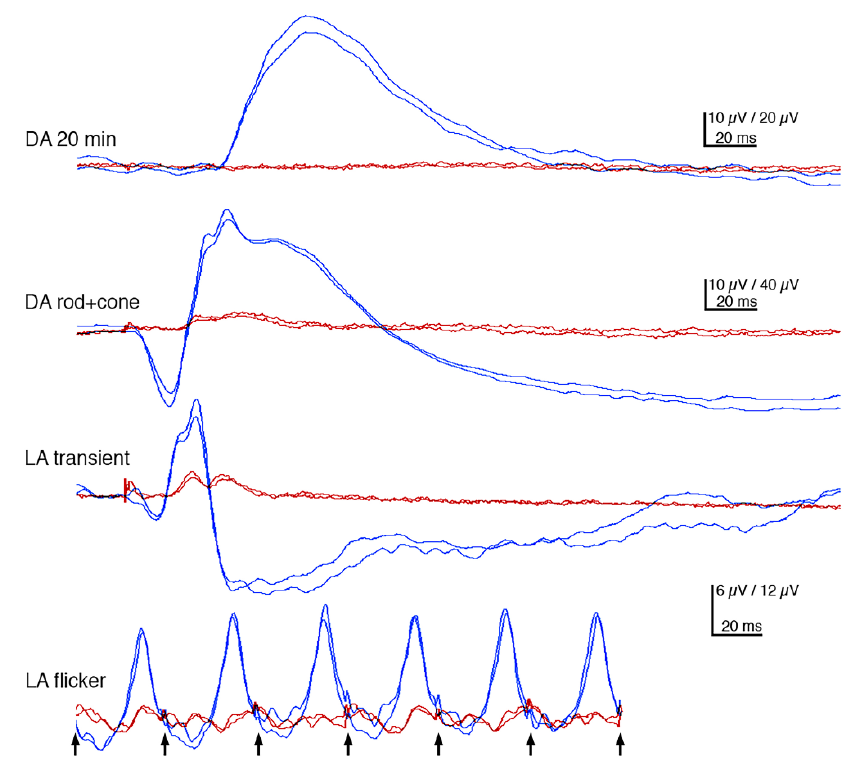
Figure 3. Flash-electroretinographs (FERGs). Both dark-adapted (DA) and light-adapted (LA) responses of the FERG had subnormal amplitudes in the affected golden retriever (GR02; red tracings) compared to the unaffected Labrador retriever (LR01) (blue tracings). Rod responses were essentially non-detectable and even the dark-adapted responses to the bright rod-cone stimulus seem to be mainly cone-driven. Light-adapted cone transients lacked a-wave and had a biphasic waveform. When a 30 Hz stimulus was employed, the cone responses of GR02 came out of sync and were not time-locked to the individual stimuli. Calibrations show the time base and the different amplitude scales for GR02 and LR01.